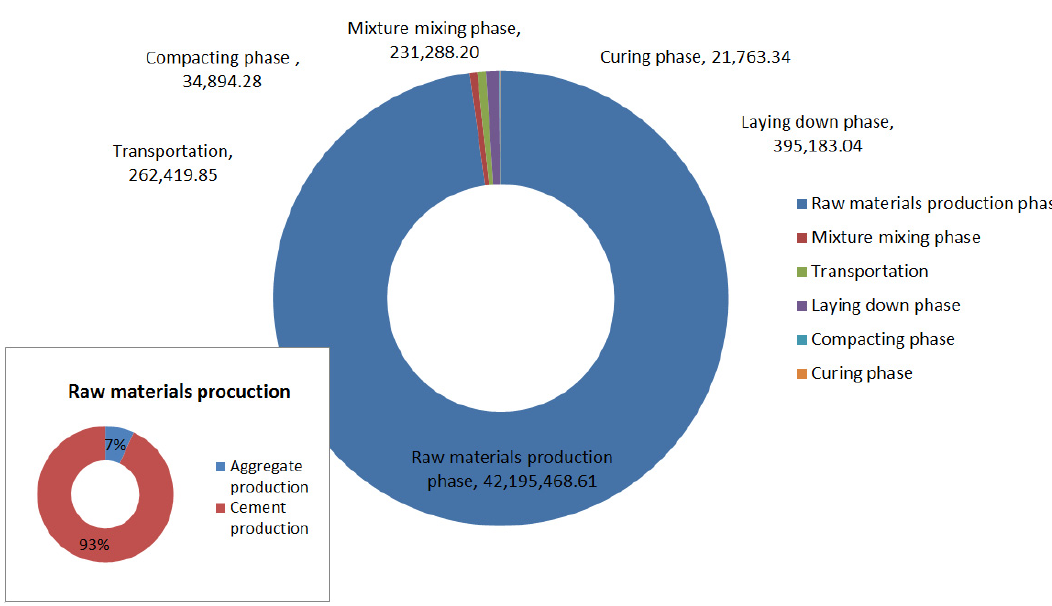
Figure 7 . CO 2 e emission of cement-stabilized aggregate base and subbase construction (unit: kg).